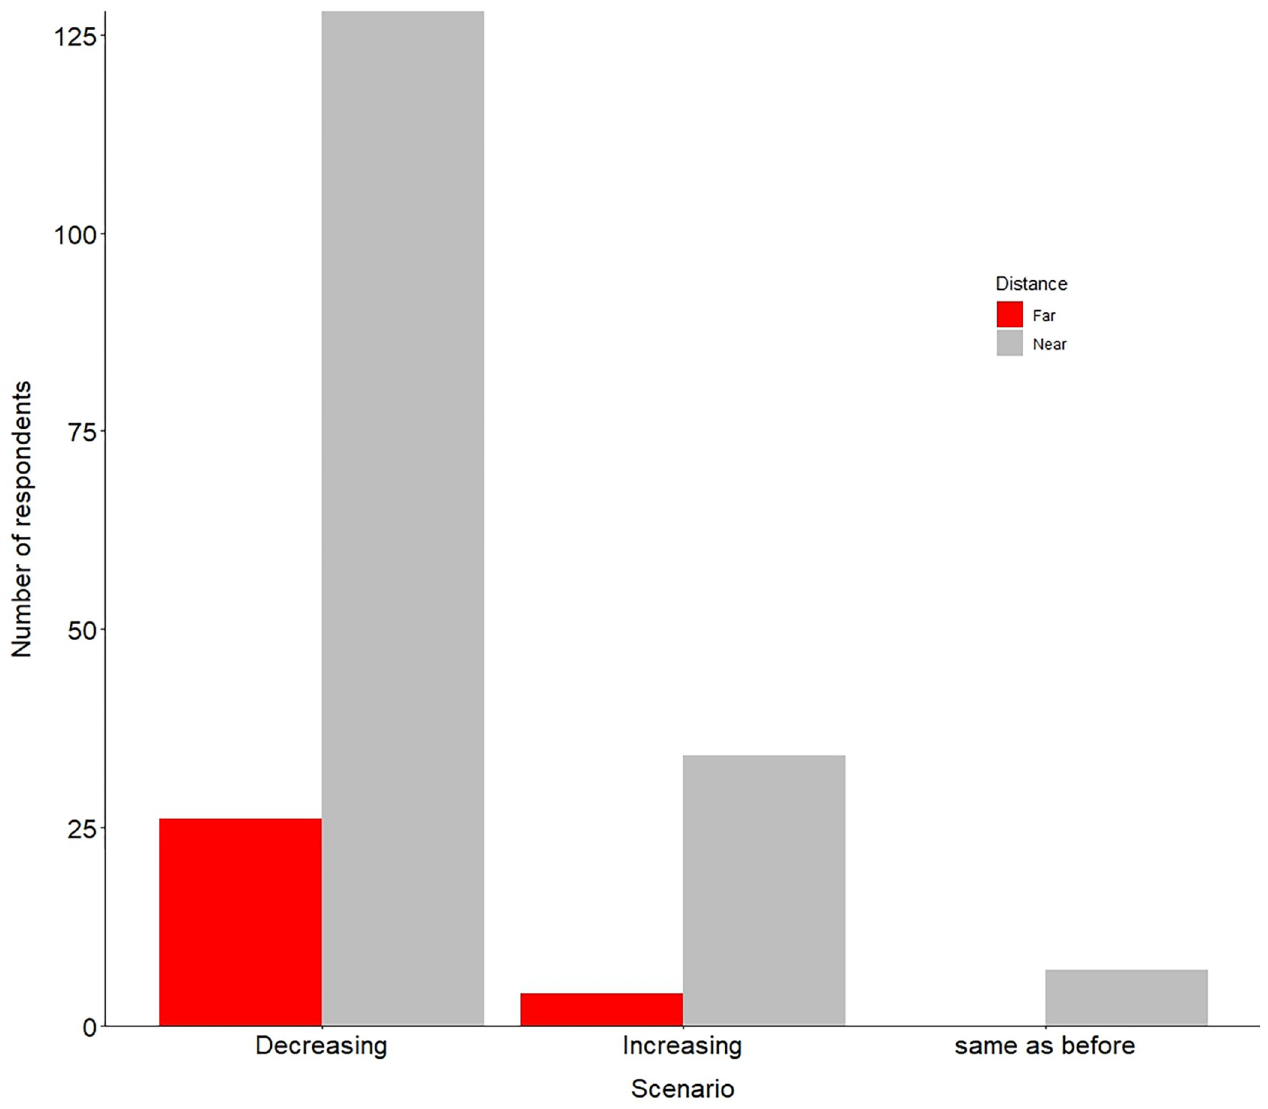
Fig 4. Number of respondent’s perception towards the scenario of human-wildlife conflict after applying mitigation measures near and far from the Shuklaphanta National Park between 2016 and 2022.